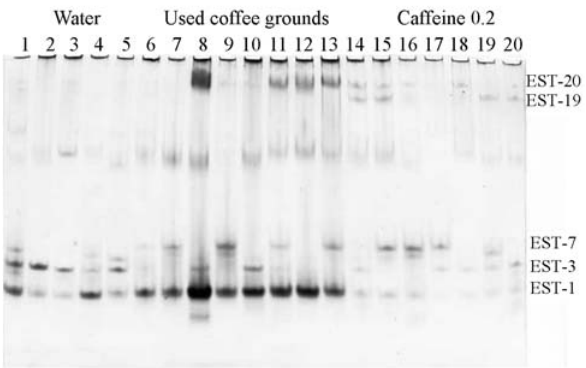
Figure 1 - Polyacrylamide gel with the esterase bands of A. aegypti (L4 stage) that showed expression variation in different mediums: control (columns 1 to 5), used coffee grounds at 25 mg/mL (columns 6 to 13) and caffeine at 0.2 mg/mL (columns 14 to 20).